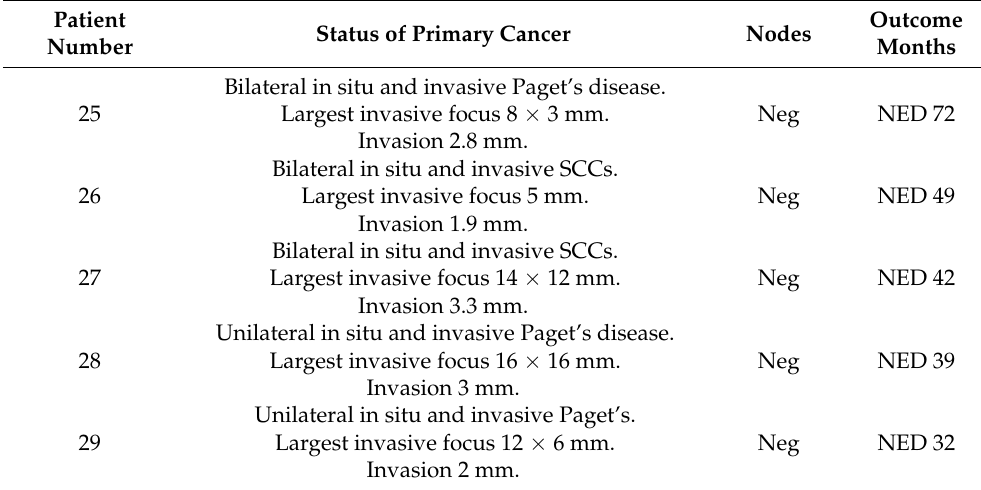
Table 3. Patients with mainly in situ carcinomas that demonstrated small, multifocal invasive disease on resection. The largest individual invasive focus was 20 mm or less in